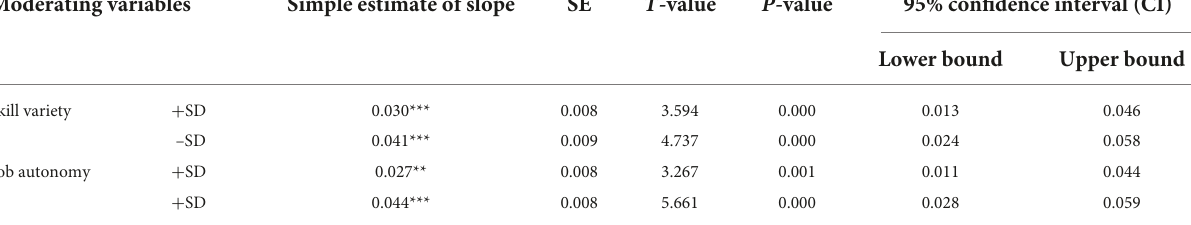
TABLE 7 Simple estimates of the slope of the moderating